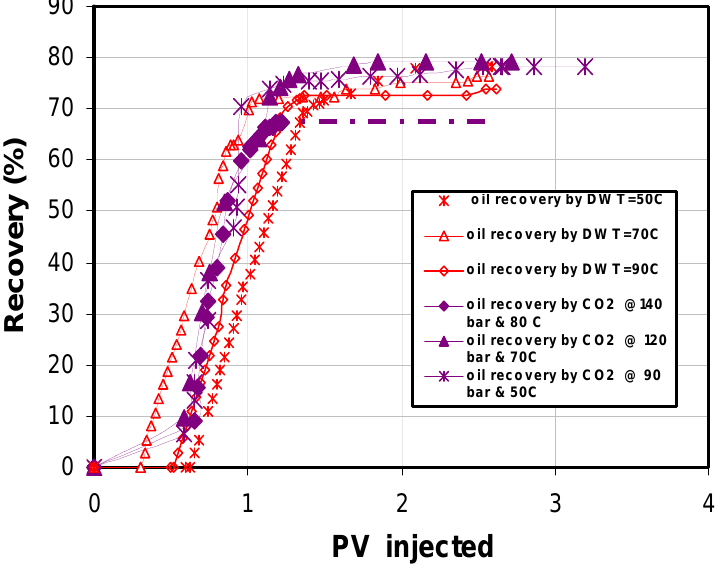
Figure 4. Comparison between oil recovery by water and CO saturated cores at 50, 70 and 80 °C (90 °C). The temperature of 90 °C in bracket is for water flooding experiments. The dotted line is an extension for the PV shift for CO flooding at 140 bar and 80 °C.